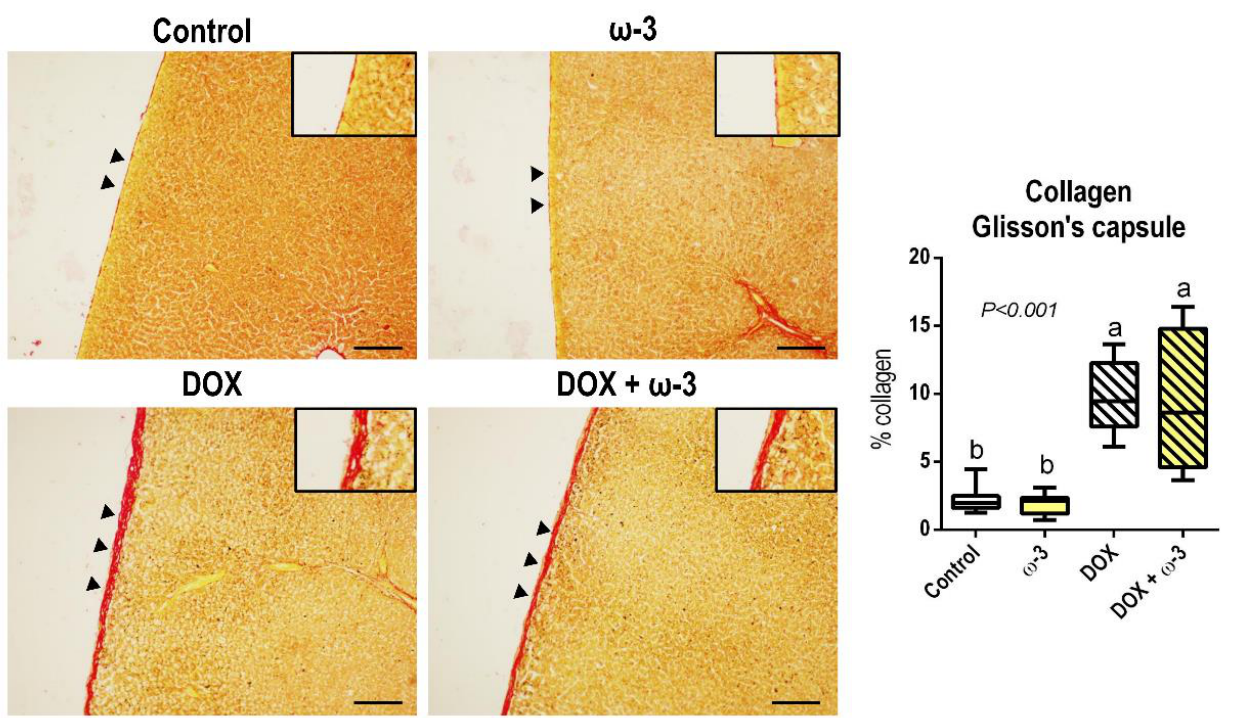
Figure 3. Effects of omega 3 ( ω -3) supplementation on doxorubicin (DOX)-induced effects on collagen area (Sirius red-stained sections) in hepatic Glisson’s capsule (arrowheads). Representative photomicrographs are presented [scale bar: 100 µ m] Data are presented as mean and standard deviation. N = 8 rats/group. Male Wistar rats received ω -3 (400 mg/kg body weight/day) by intragastrical administrations for six weeks (or vehicle). After two weeks of ω -3 supplementation, animals received weekly single intraperitoneal injections of DOX (3.5 mg/kg body weight) for four weeks (or vehicle). The letters correspond to the statistical difference among groups by Kruskal-Wallis followed by a posteriori Tukey test ( p < 0.05).